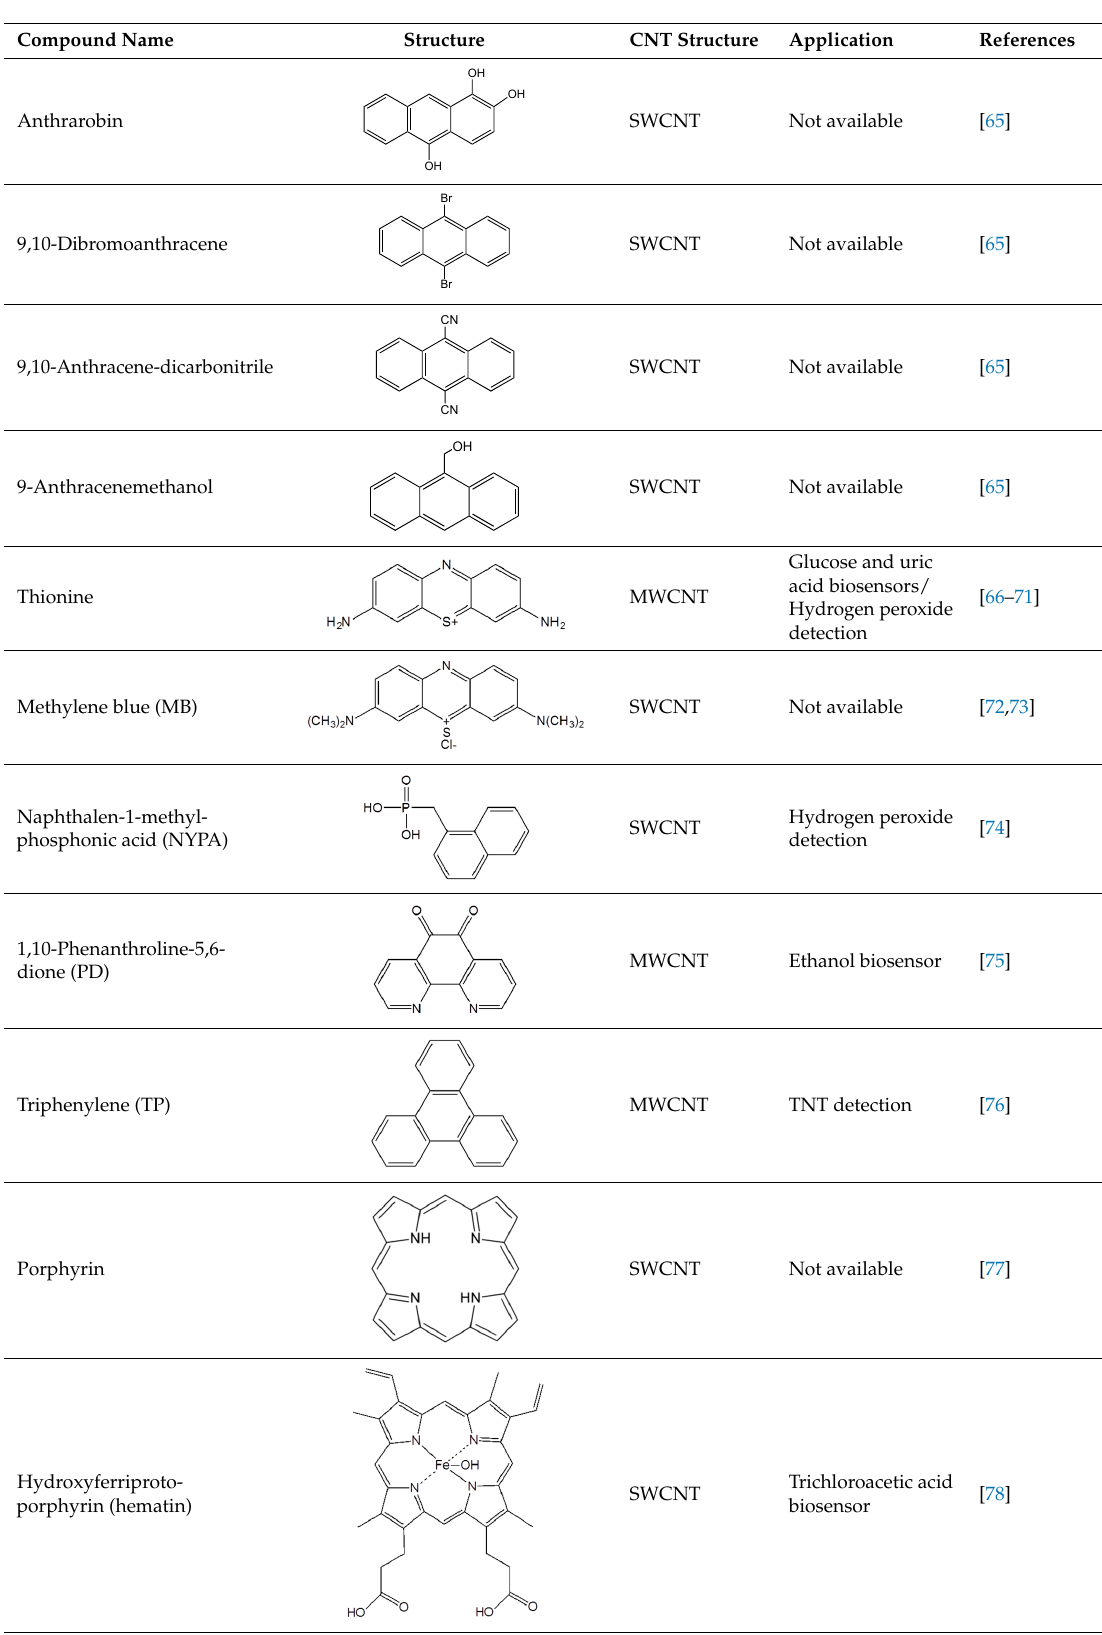
Figure 5. ( A ) SWCNT functionalized with pyrene-based molecular tether, 1-pyrenebutanoic acid, succinimidyl ester (PBSE) (adapted with permission from Zhao et al. Copyright (2018) American Chemical Society) [45]; ( B ) Anchored PBSE for immobilization of proteins on SWCNT (adapted with permission from Chen et al. Copyright (2018) American Chemical Society) [50]; ( C ) Multicopper oxidase immobilized on MWCNT using PBSE [55]. The PBSE being a hetero-bifunctional cross-linker, conjugates with both MWCNT and multi- copper oxidase effectively and thus facilitating the direct electron transfer between the MWCNT electrode and the enzyme for bio-electrocatalytic oxygen reduction. Giroud et al. also investigated the use of anthracene grafted pyrene derivatives to achieve direct electron transfer of laccase in oxygen reduction [64]. Multiple functionalization of SWCNTs through π - π stacking was achieved by Holzinger et al. via simple dip coating process. The functionalization was established by attaching three different pyrene derivatives onto CNTs sidewalls for the construction of glucose biosensors, including adamantane–pyrene, biotin–pyrene, and nitrilotriacetic acid (NTA)–pyrene. The prepared multifunctional electrodes were then immobilized with β -cyclodextrin modified glucose oxidase ( β - CD-GO x ), biotinylated glucose oxidase (B-GO x ) and histidine modified glucose. The functionalization method could be applied to any kind of nanotube modified surface and nanotube fibers [61]. Wei et al. developed an impedance sensor for determination of polychlorinated biphenyl based on SWCNT/ pyrenecyclodextrin hybrid [79]. With the aid of pyrenyl group, CD could attach to the sidewalls of CNTs by means of π - π stacking. The established system is highly sensitive and selective to polychlorinated